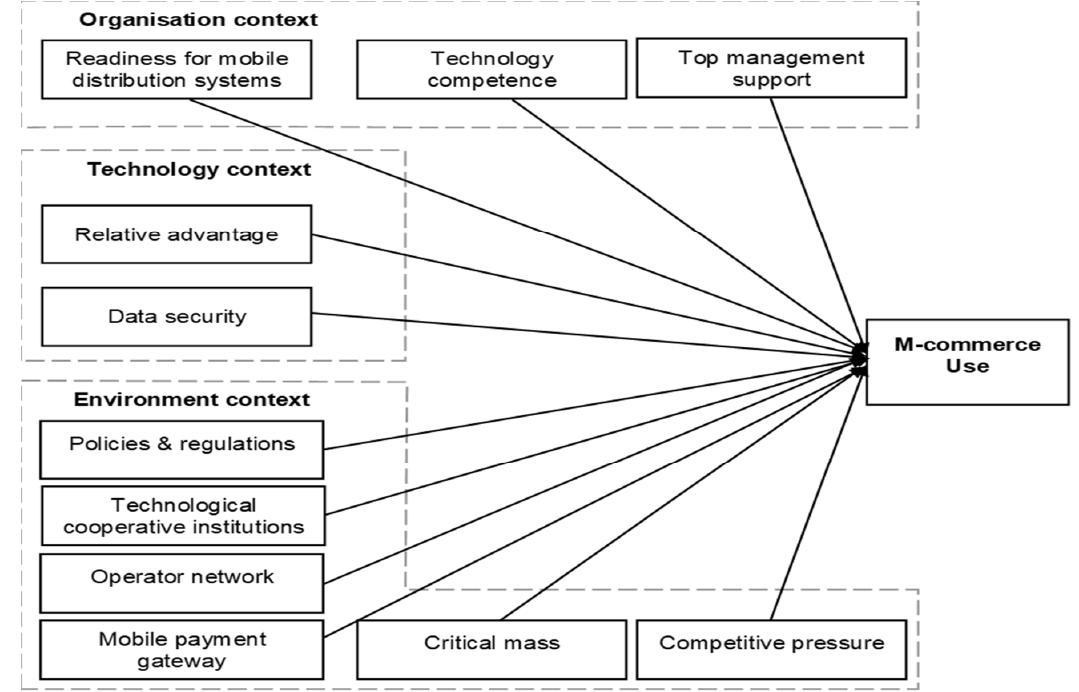
Figure 1. Conceptual